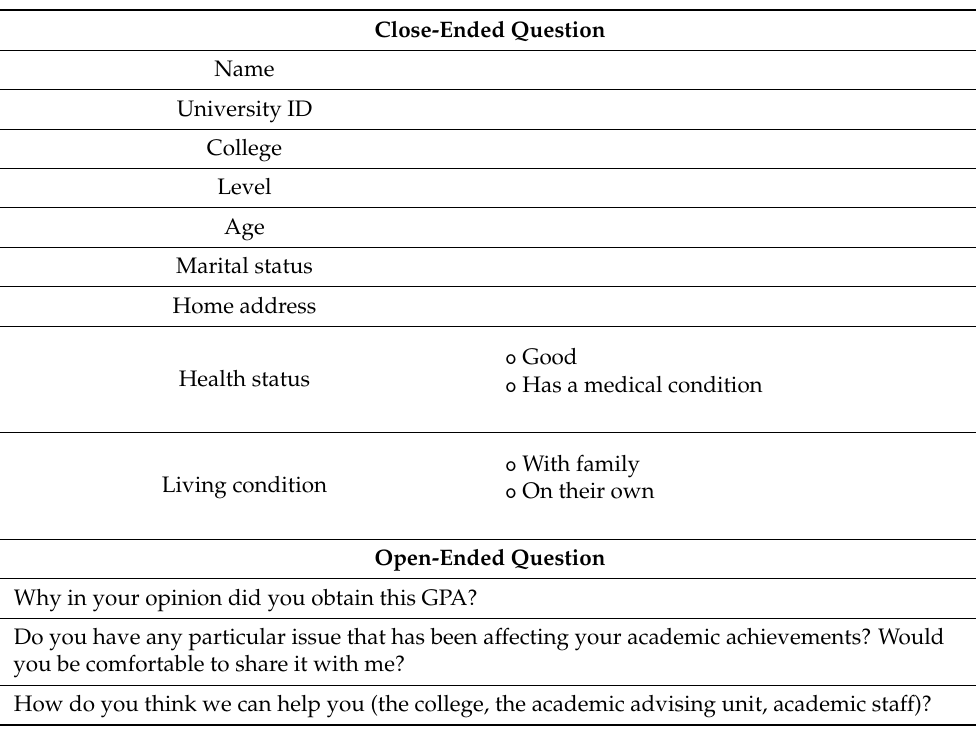
Table 1. Interview guide.